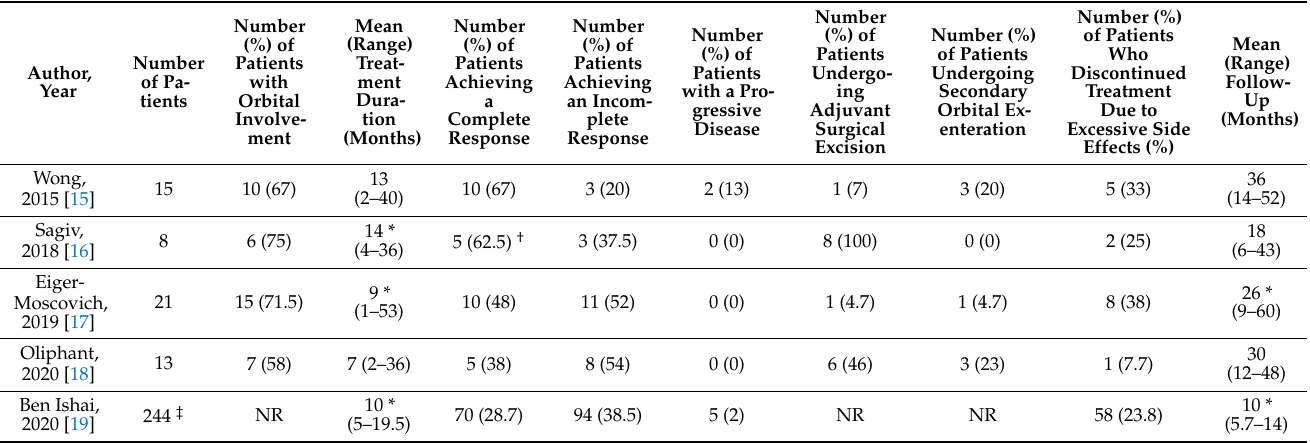
Table 1. Main studies that assessed anti-SMO targeted therapies in locally advanced periocular